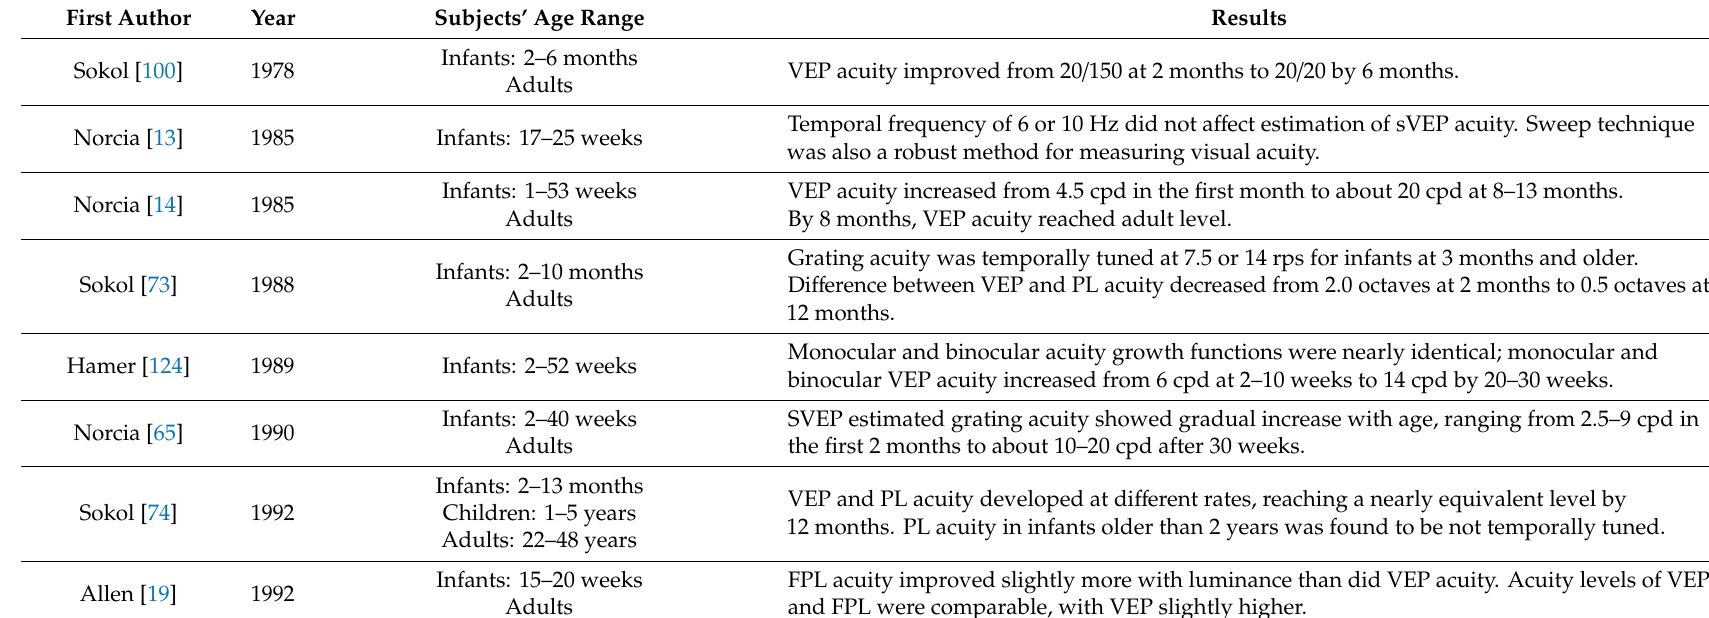
Table 2. Studies of visual acuity development using